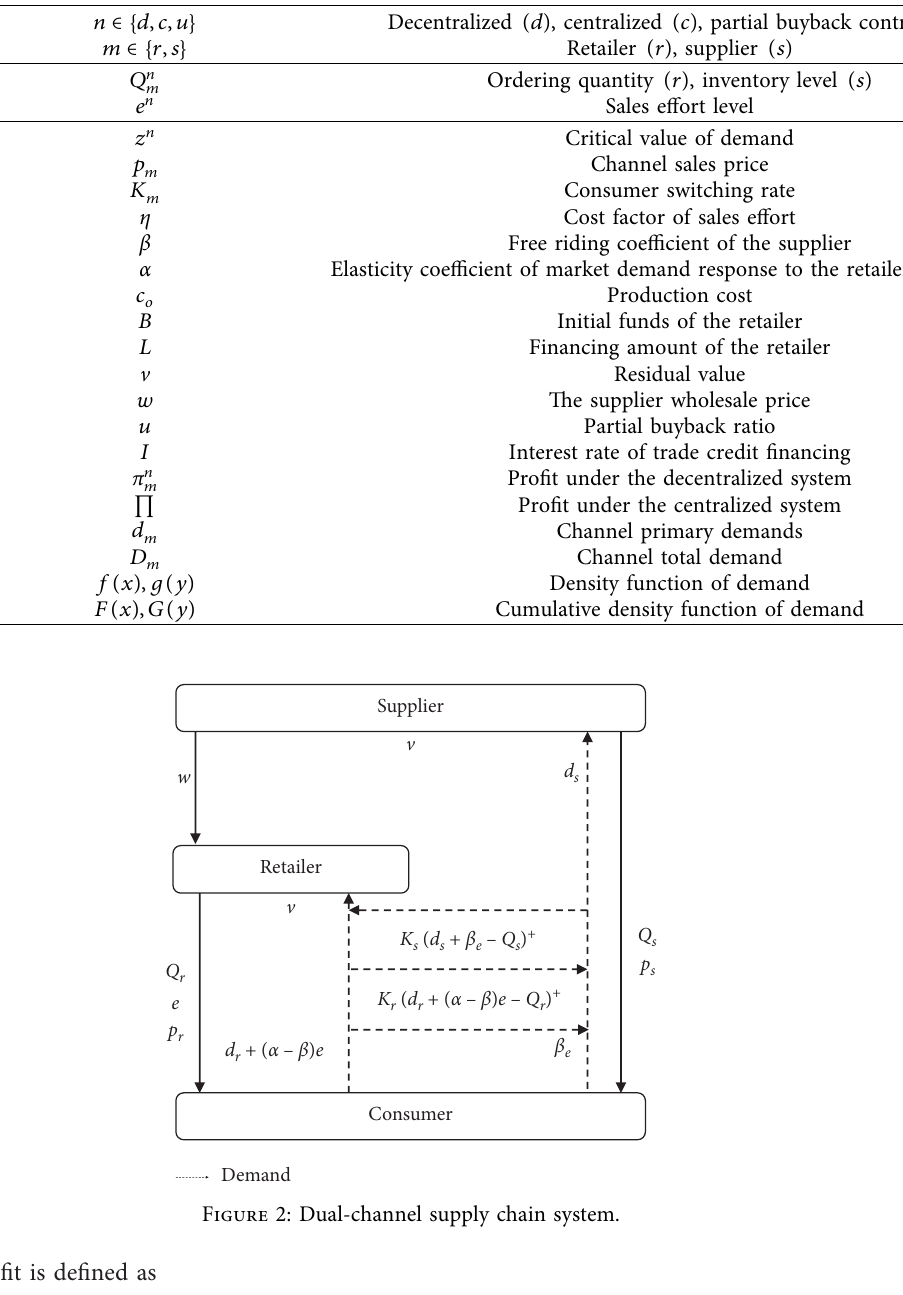
Table 2: Notation